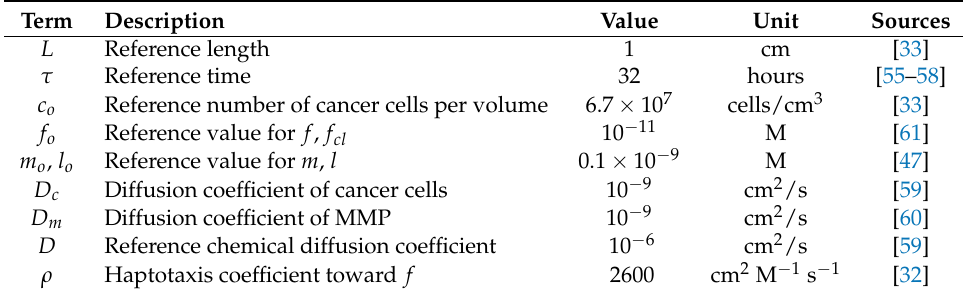
Table 1. Parameter values available from the literature used in the model of metastatic invasion of cancer through remodeling